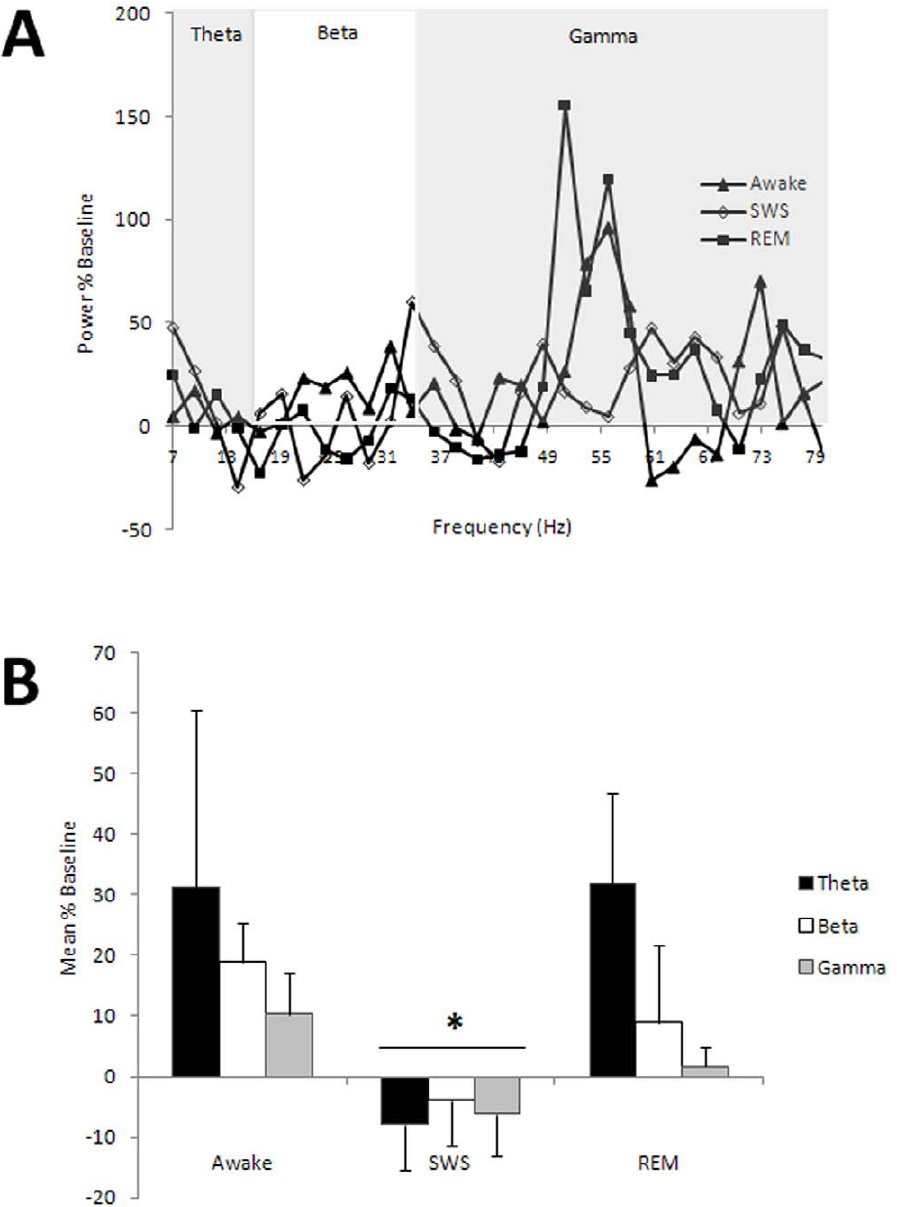
Figure 2. Odor evoked activity in the piriform cortex changes across behavioral states. ( A ) Representative odor evoked anterior piriform cortex activity during awake, REM, and SWS from one animal. During both awake and REM odor stimulation increased activity in the gamma (35– 85 Hz) frequency band. There was no obvious odor-evoked activity in the piriform cortex during SWS. ( B ) During Awake and REM, there was significantly greater odor evoked activity in all frequency bands (mean odor-evoked activity 6 SEM) compared to